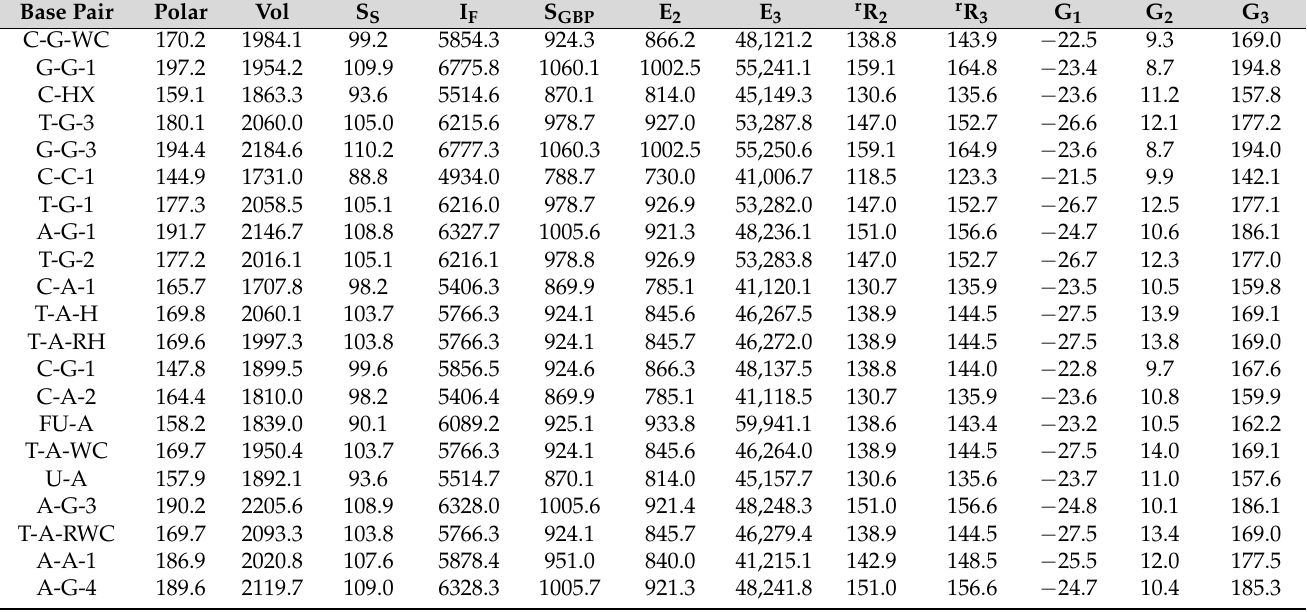
Table 3. Molecular polarizabilities (in Bohr 3 ), molecular volumes (in Bohr 3 /mol), and ITA quantities (in a.u.) for 30 base